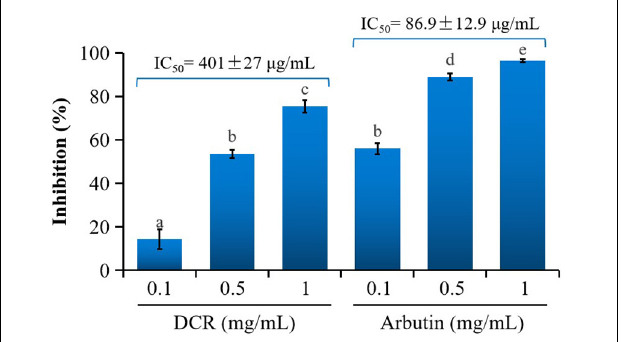
FIGURE 2 | The effect of Dryopteris crassirhizoma rhizome (DCR) on (A) melanogenesis in zebrafish embryos and (B) melanin content of zebrafish embryos. Different lower case letters indicate significant differences ( p < 0.05).